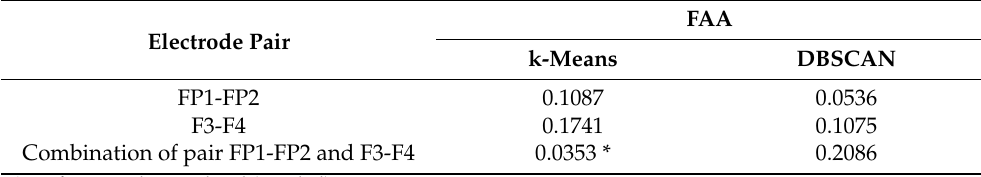
Table 7. The p -value of Wilcoxon signed-rank test for the FAA at respective electrode pairs. Electrode Pair